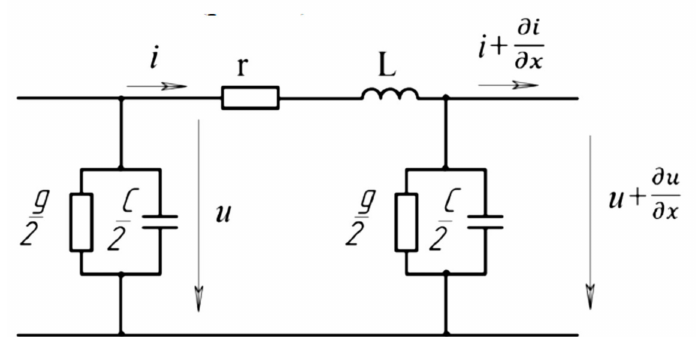
Figure 2. U-shaped equivalent circuit of